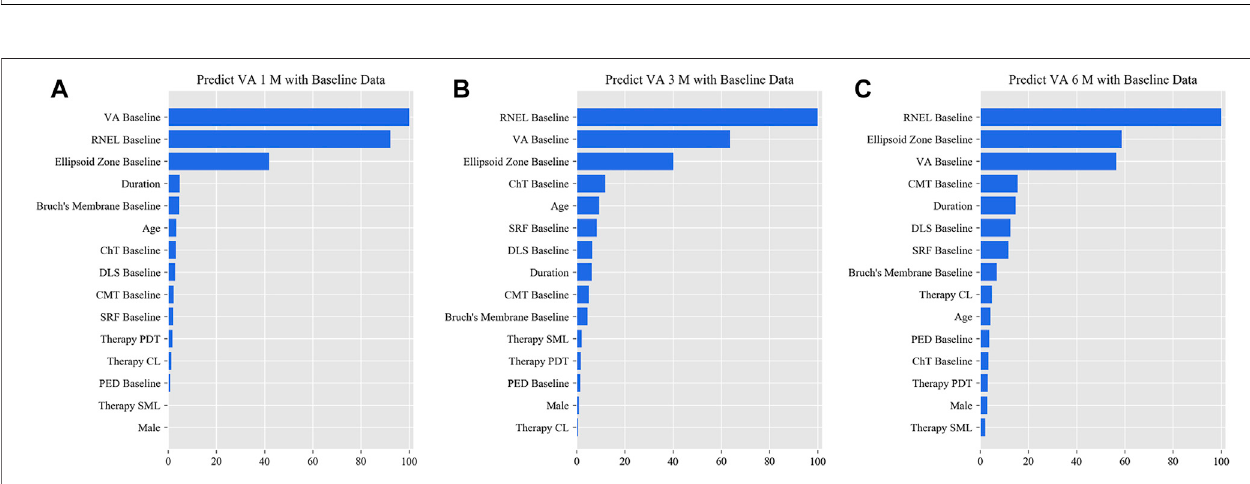
FIGURE 4 | Relative importance of different features of prediction for the full model. These plots show the weights of the different features in the VA prediction task 1, 3, and 6 months after laser treatment in the full model. The results were strati fi ed according to the follow-up period and the points input into the algorithms; this fi gure shows only the relative importance of the baseline data. The red bar indicates the average importance of the feature in the blending algorithm. (A) Feature weights in the 1-month VA prediction. (B) Feature weights in the 3-month VA prediction. (C) Feature weights in the 6-month VA prediction. VA, visual acuity; RNEL, retinal neuroepithelial layer; ChT, choroidal thickness; CMT, central macular thickness; DLS, double-layer sign; PDT, photodynamic therapy; SRF, subretinal fl uid; ICGA, indocyanine green angiography; PED, pigment epithelial